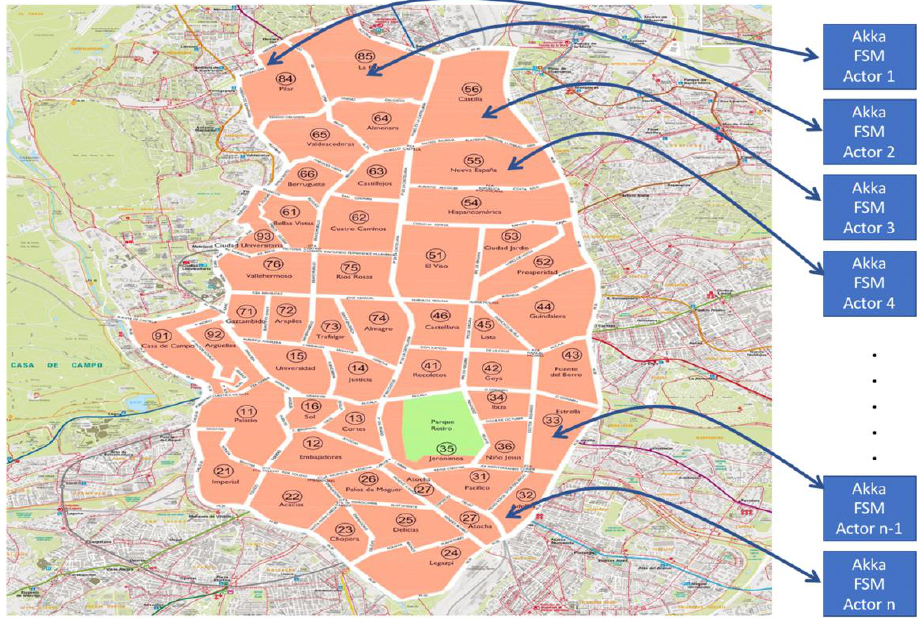
Figure 14. FSM Akka actors to manage reservations in the urban center of Madrid.